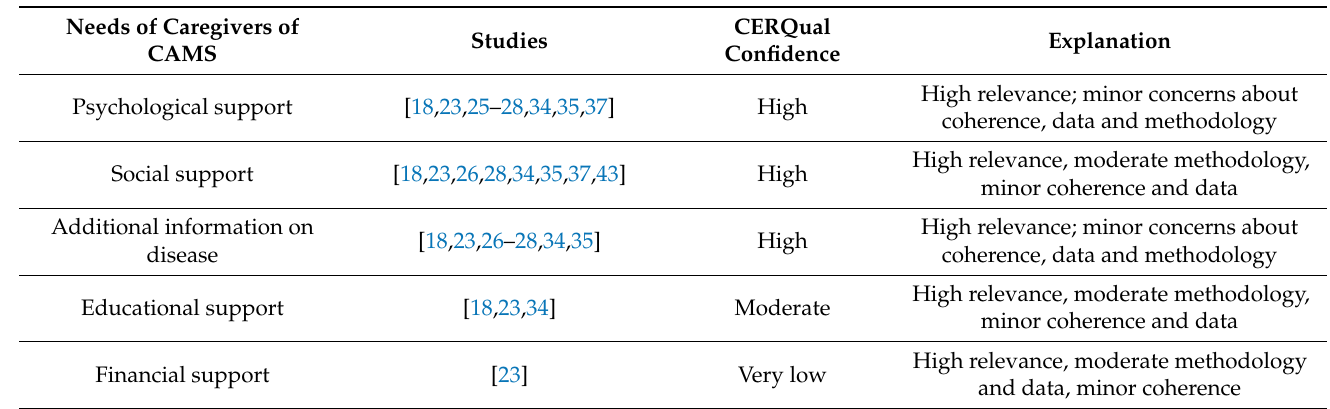
Table 4. The needs of families of